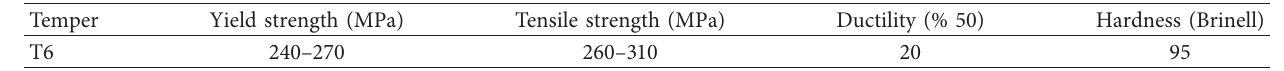
Table 2: Mechanical properties of AA 6061 alloy.